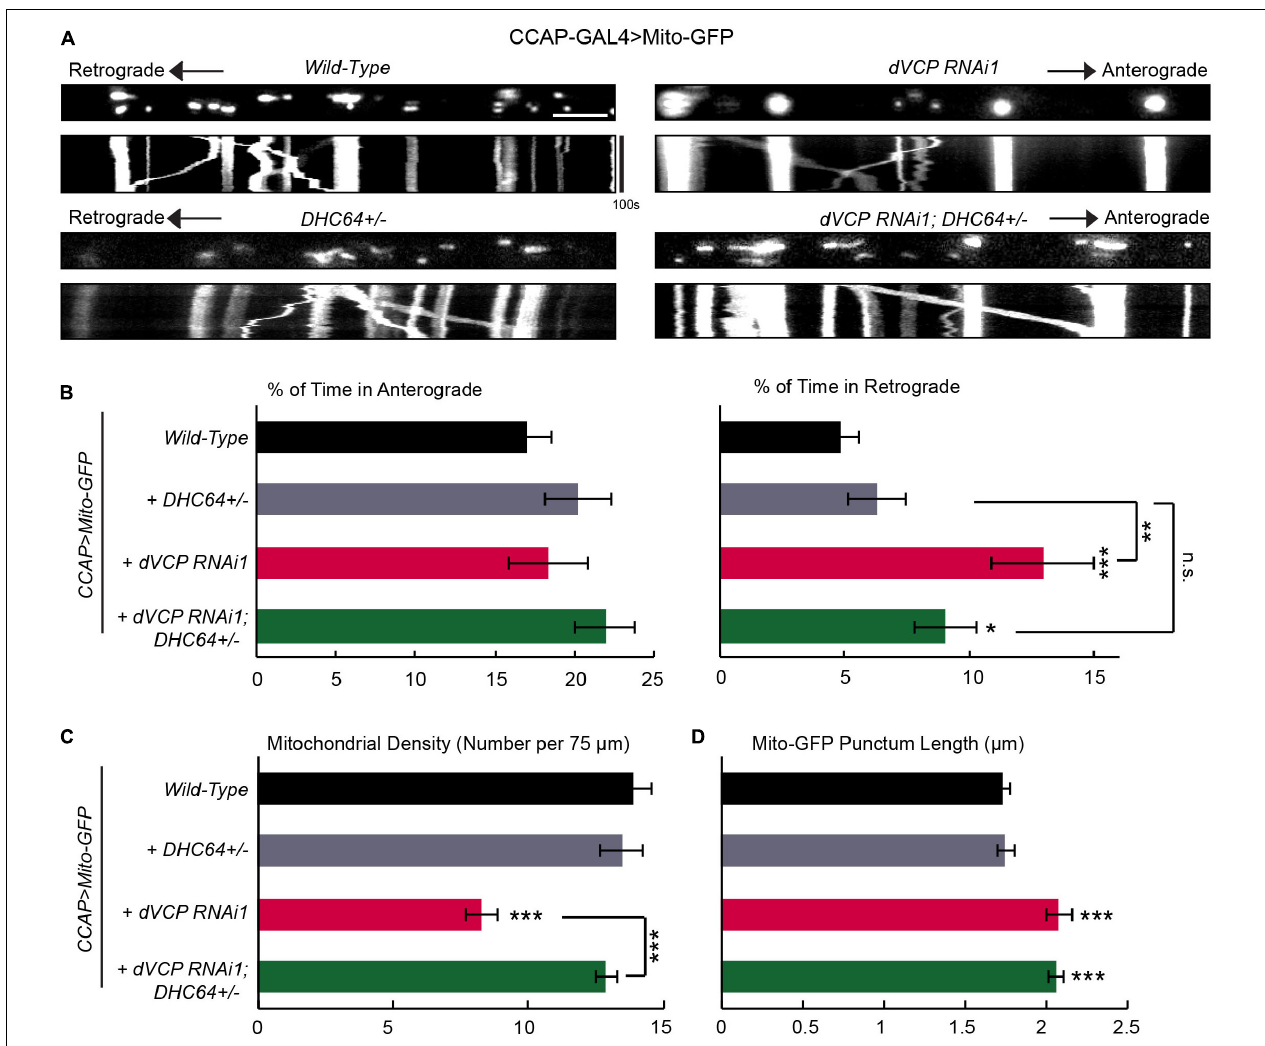
FIGURE 2 | dVCP genetically interacts with dynein to regulate mitochondrial transport. (A) Mitochondrial movement labeled by Mito-GFP driven by CCAP-GAL4 in representative axons passing segment A3. The first frame of each live-imaging series is shown above a kymograph generated from the movie. (B) The percent of time each mitochondrion spends moving in the anterograde and retrograde directions is determined and averaged ( n = 183–401 mitochondria). (C) The density of mitochondria (number per 75 µ m) is shown ( n = 13–31 axons). (B,C) Two-way ANOVA test reveals a significant difference between the impact of DHC64C + / − on wild-type and on dVCP RNAi for retrograde movement ( P = 0.035) and density ( P < 0.001). (D) The length of each Mito-GFP punctum is quantified and averaged ( n = 183–401 mitochondria). For B–D , 13–31 axons were imaged from 6–12 larvae per genotype. Comparisons with “ CCAP-GAL4 > Mito-GFP, Wild-Type ” (same data as in Figure 1 ) unless otherwise indicated. Scale bar = 7.5 µ m. * P < 0.05, ** P < 0.01, *** P <